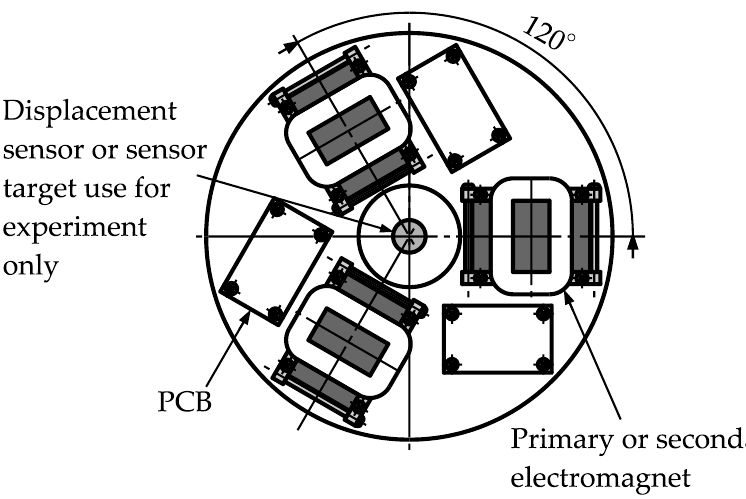
Figure 11. Layout of the stator and the floator. Three electromagnets and PCBs are installed to the stator and the floator. The secondary circuit with a capacitor and a power consumption load is installed each PCB on the floator. A sensor and its target are temporarily installed to the center of the stator or the floator, respectively, for the following experiment.